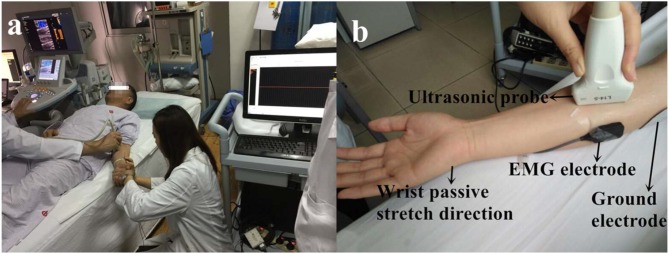
The experimental setup (a) and detailed position of the probe and EMG electrode on the muscle (b). Consent was obtained from the individual for the publication of this image.